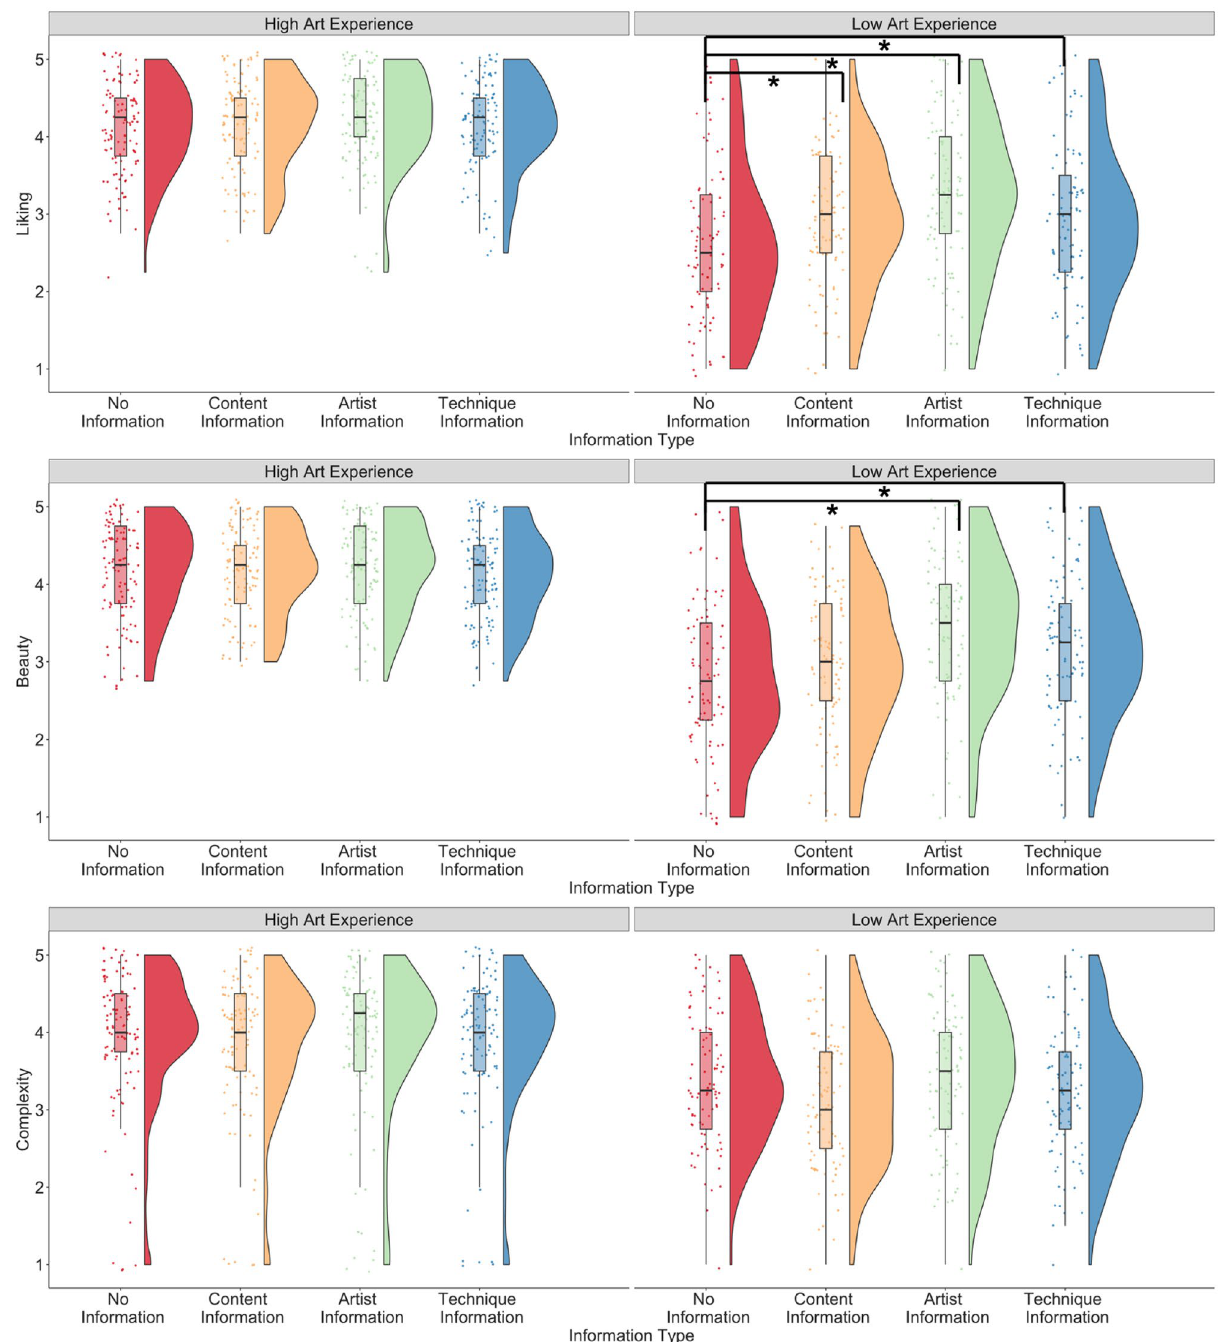
Figure 3. Liking, beauty, and complexity ratings when no contextual information was provided to participants, and when information about the artist, information about the content, and information about the technique was provided to participants, split by participants with high and low art experience. *p <